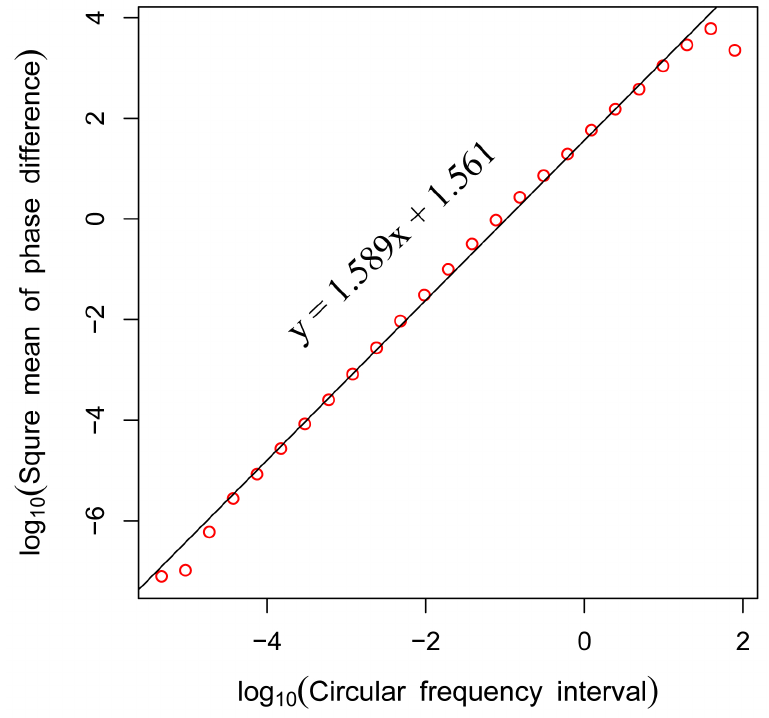
Figure 2. Relationship between the variance of the phase difference and circular frequency